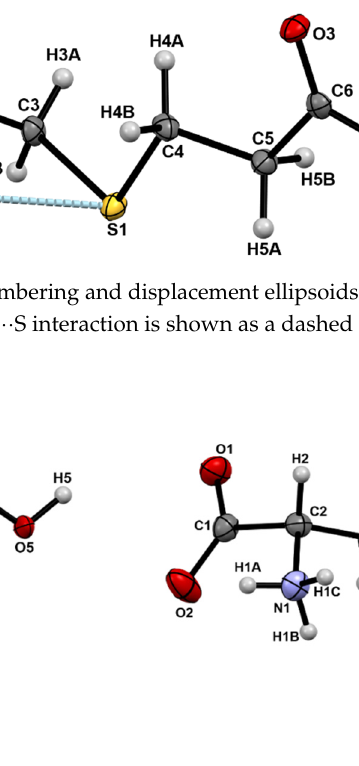
Figure 2. Molecular structure of S -(2-carboxyethyl)- L -cysteine sulfoxide. ( a ) Atomic numbering and displacement ellipsoids at the 50% probability level for (4 R )- β -CECO. Intramolecular N-H···O interactions are shown as dashed lines. ( b ) Atomic numbering and displacement ellipsoids at the 50% probability level for (4 S )- β -CECO.